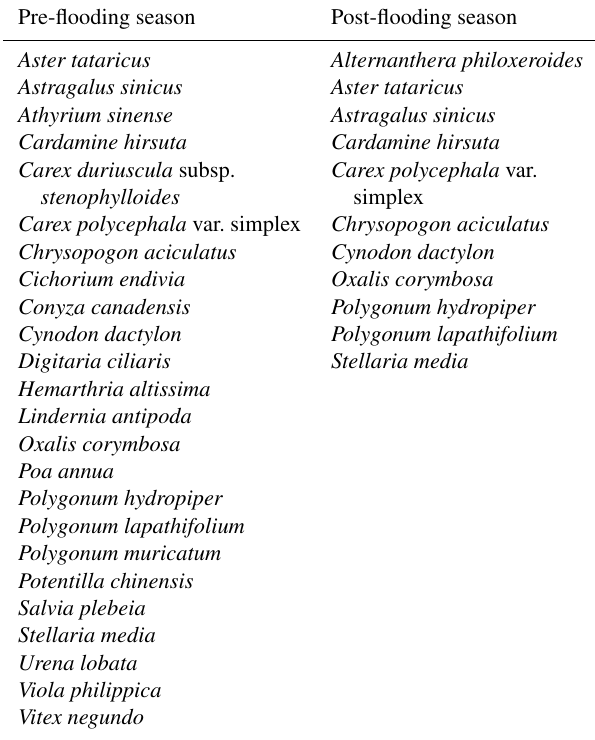
Table A3. The whole plant species in pre-flooding season (surveyed in April) and post-flooding season (surveyed in